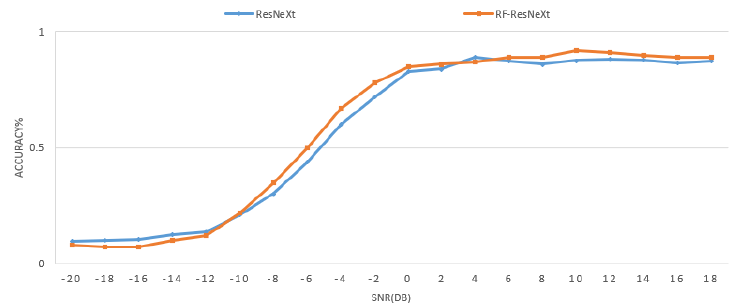
Figure 8. Performance comparison before and after improvements.